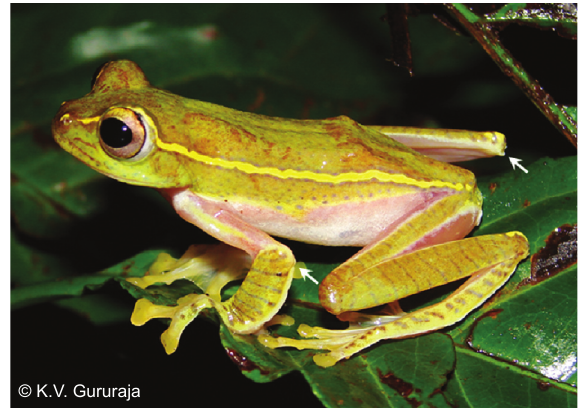
Image 3. Post-metamorphic tadpole of R. lateralis groin; entire hind arm, lateral sides and ventral sides of the thigh, transparent; fore arm and dorsal surface of the hind legs striped with broad yellowish-green to brownish- green and narrow dark brown or black bands. Notably, the one individual collected and the few individuals sighted in the field had the prominent spur in front of the joint of the hind arm and the forearm. We observed a post-metamorphic froglet (Image 3), which was green in colour with black spots over the dorsum and along the sides of the body having only the limbs barred without any distinctive dorsolateral yellow streak from the nostril to the groin along the outer edge of the upper